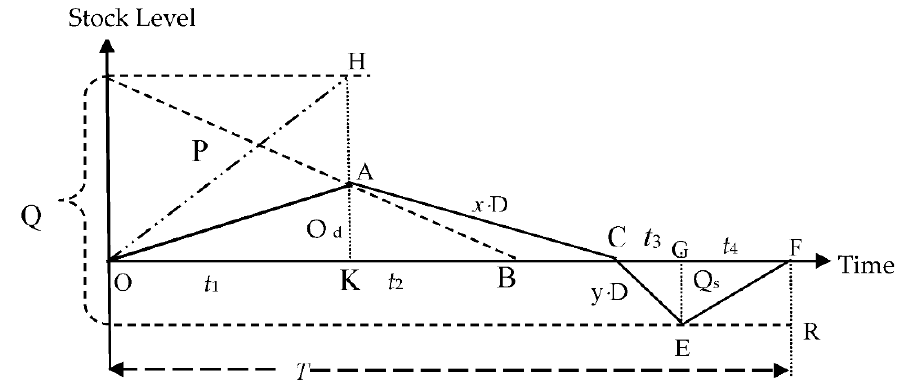
Figure 2. On-hand stock flow for x < 1 and y > x .